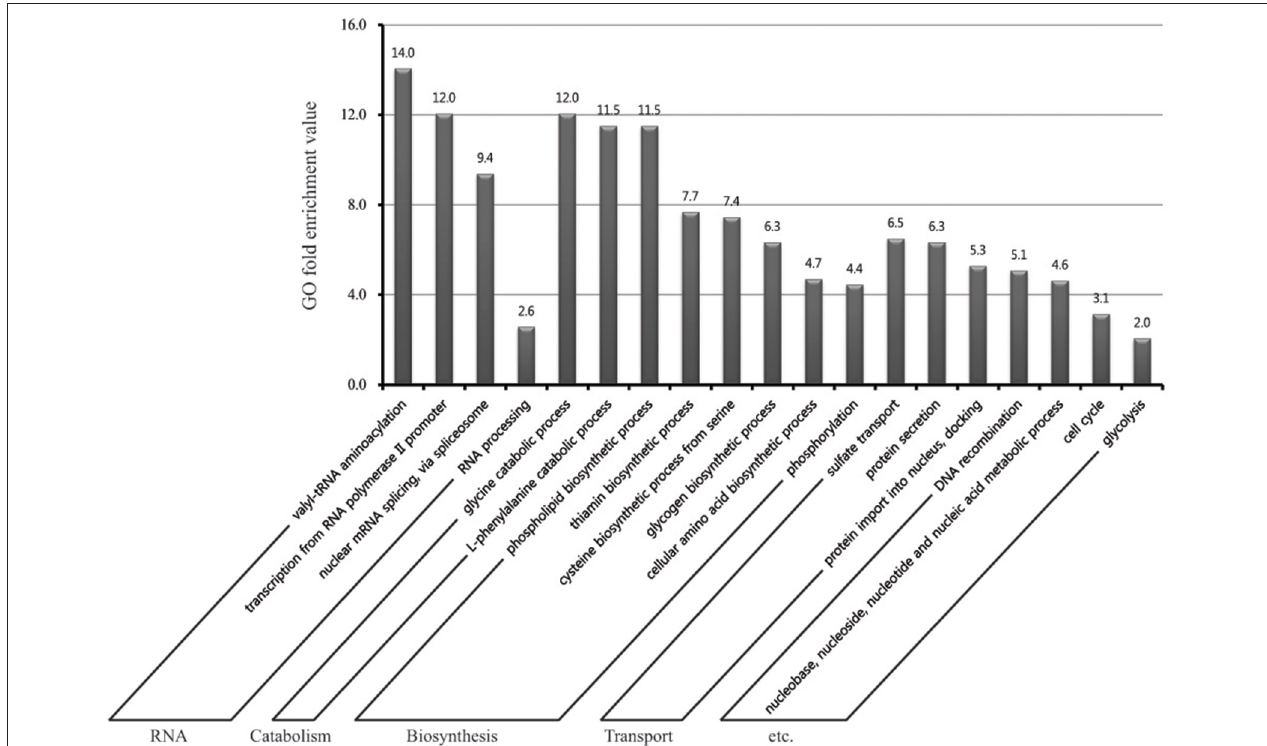
FIGURE 5 | Gene ontology (GO) enrichment analysis in “biological process” category for genes up-regulated in response to water deficiency. In all, 19 GO terms were over-represented under > 2-fold enrichment value, with p < 0.05. Details of GO assignments are presented in Table S5